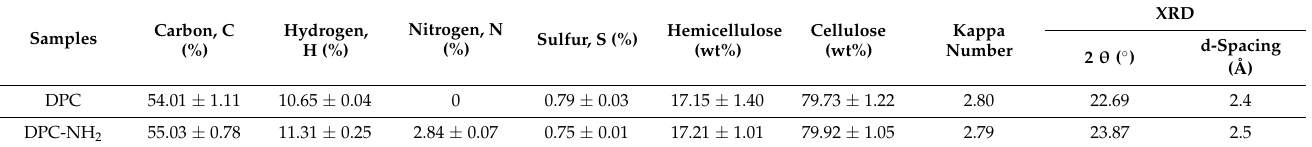
Table 1. Composition of DPC and DPC-NH 2.